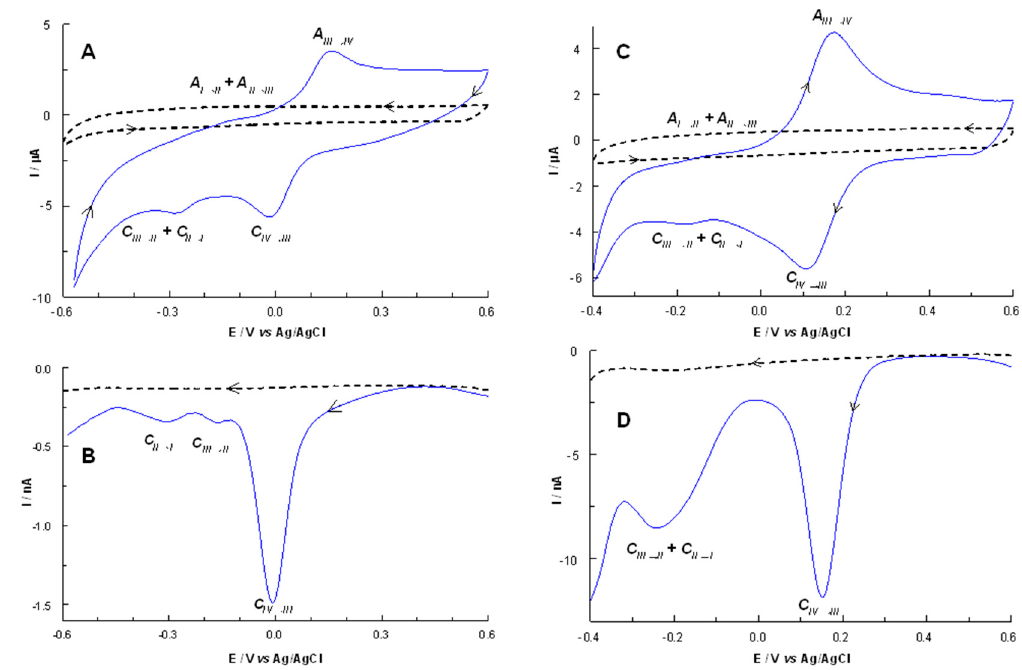
Figure 7. CV ( A , C ) and DPV ( B , D ) curves recorded in acetonitrile/ethanol solution containing 0.1 M TBAPF 6 and 1 mM ruthenium complexes 1 and 2 ( ― ) or 1 mM ligands ( _ _ _ ) on the first day of